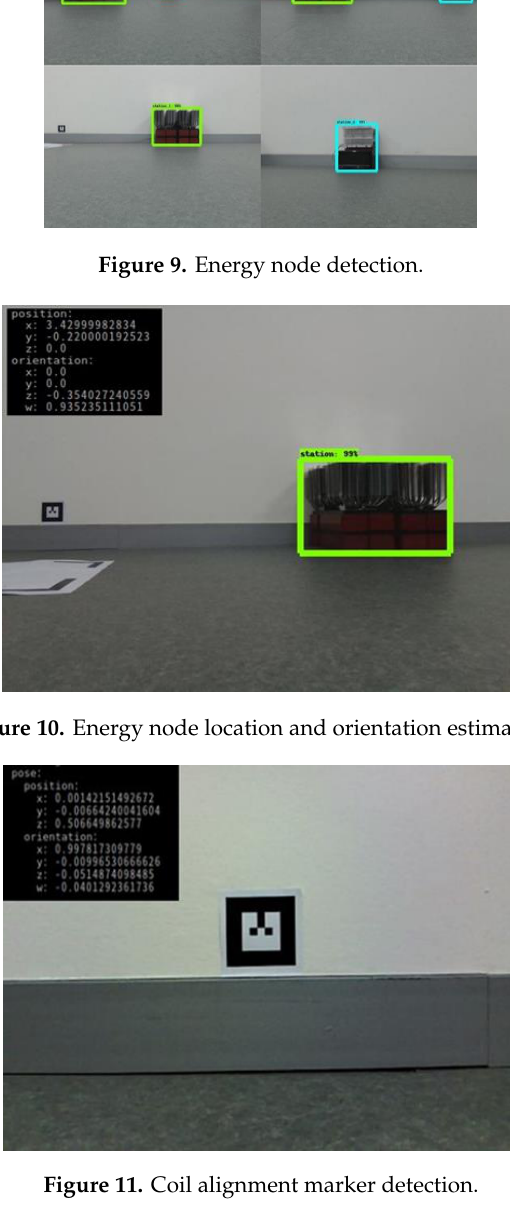
Figure 11. Coil alignment marker detection.